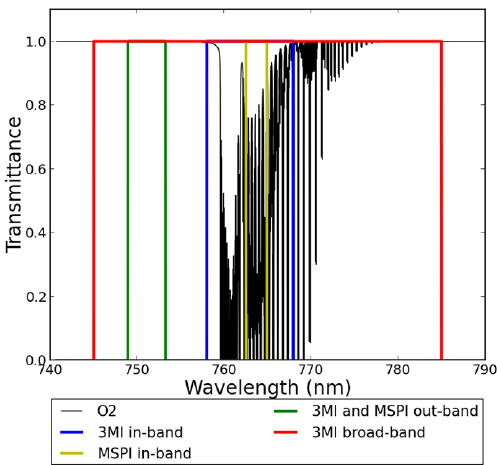
Figure 1. 3MI’s filter models. The O 2 transmittance is indicated by the black line. The green line represents the out-band filter (748.95– 753.25nm), the red the broad-band (745–785nm), the blue 3MI’s in- or thin band (758–768nm), and the yellow line MSPI’s in-band